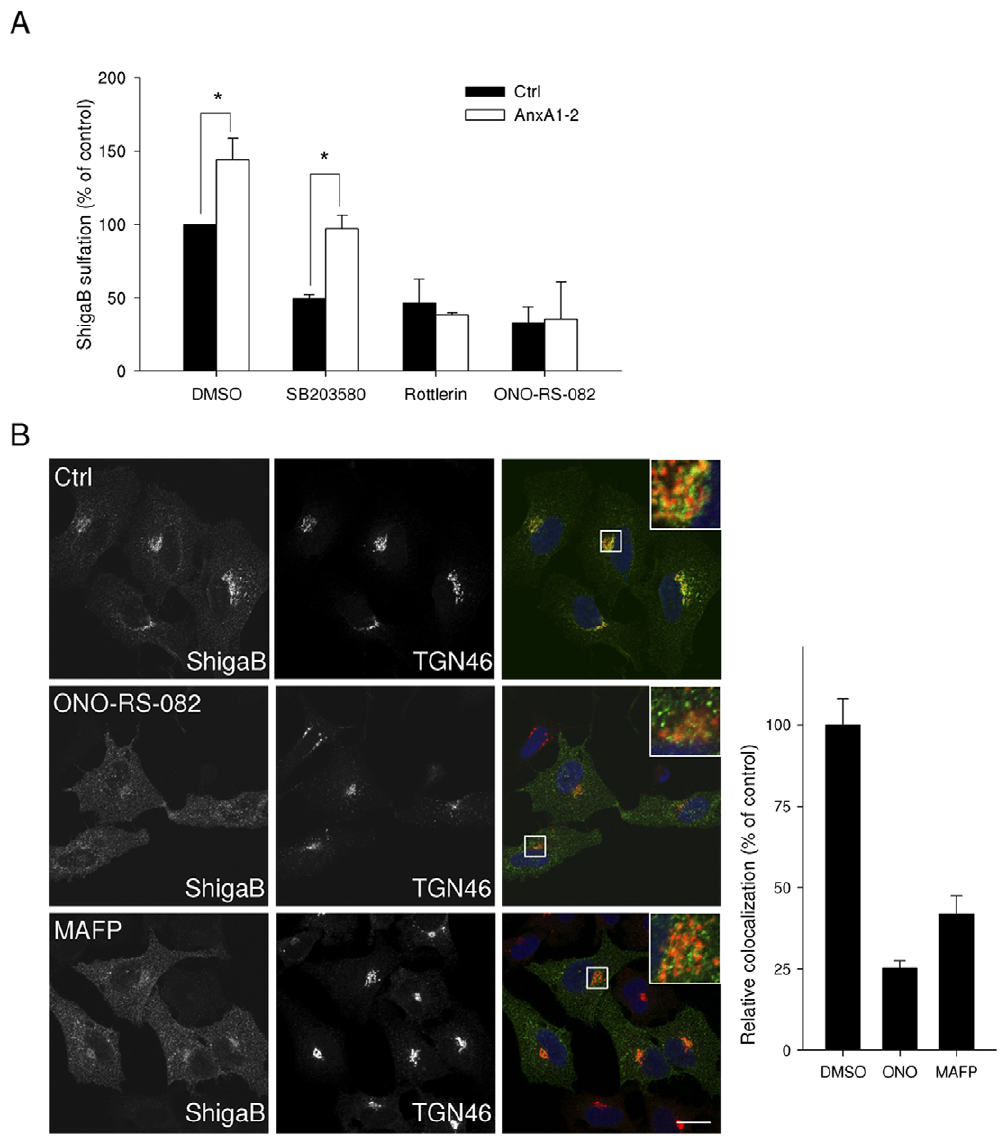
Figure 4. Stx transport in annexin A1 depleted cells is regulated by PKC d and PLA2. (A) Golgi transport of Shiga toxin was evaluated as described in materials and methods by quantification of sulfated ShigaB in HeLa cells transfected with siRNA against annexin A1 or non targeting siRNA, pretreated with the indicated inhibitors. Data from Stx sulfation are plotted as percentages of the value obtained for HeLa cells transfected with control siRNA and treated with DMSO. The white and black bars represent ShigaB-sulf2 sulfation for control and annexin A1 knockdown cells respectively. Data presented are the average of 3 independent experiments, each performed in parallel, error bars indicating standard error of the mean. *p , 0.05 indicates statistically significant change between annexin A1 knockdown cells and the corresponding control siRNA treated cells. (B) After treatment with either 5 m M ONO-RS-082 for 30 min or 30 m M MAFP for 1 h, HeLa cells were incubated for 30 min with ShigaB before fixation and staining as indicated in the material and methods section with antibodies against TGN46 and ShigaB. Panel shows representative confocal pictures, scale bars 20 m m. Graphic shows quantification of amount of ShigaB colocalized with TGN46 in one representative experiment plotted as percentage of control condition. Data presented for one representative experiment (n=3) are the average of at least 30 cells per condition. Quantifications were obtained with Zen 2009 software from Zeiss, error bars indicating standard error of the mean.